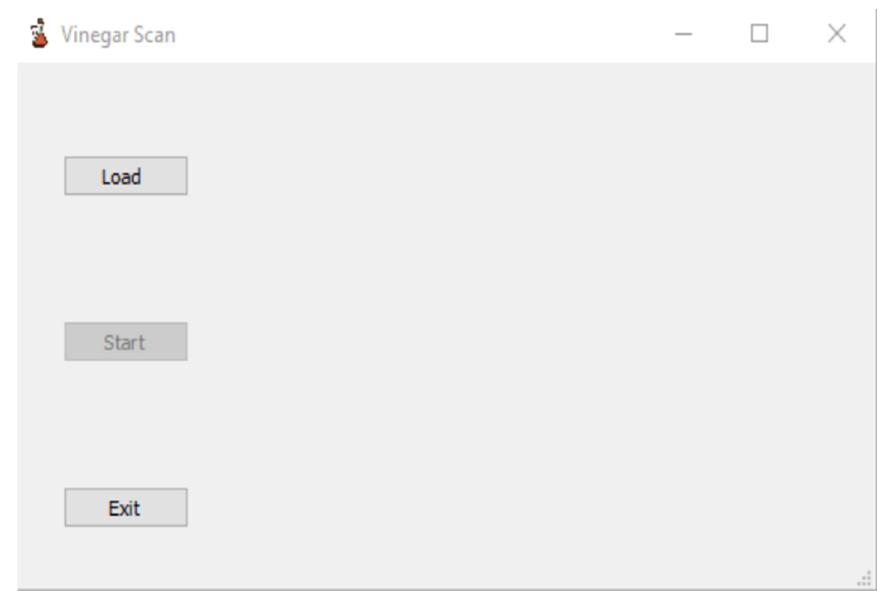
Figure 5. Main screen of the graphical user interface (GUI) for the VinegarScan tool.